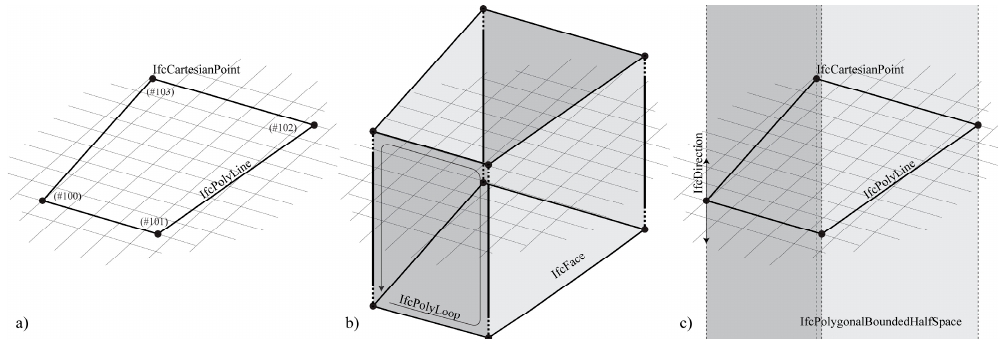
Figure 9. Three ways to represent a traditional parcel column: ( a ) footprint, ( b ) open shell with vertices near infinity, ( c ) the union of two IfcPolygonalBoundedHalfSpaces to represent a prism up to infinity and down to the Earth’s core.